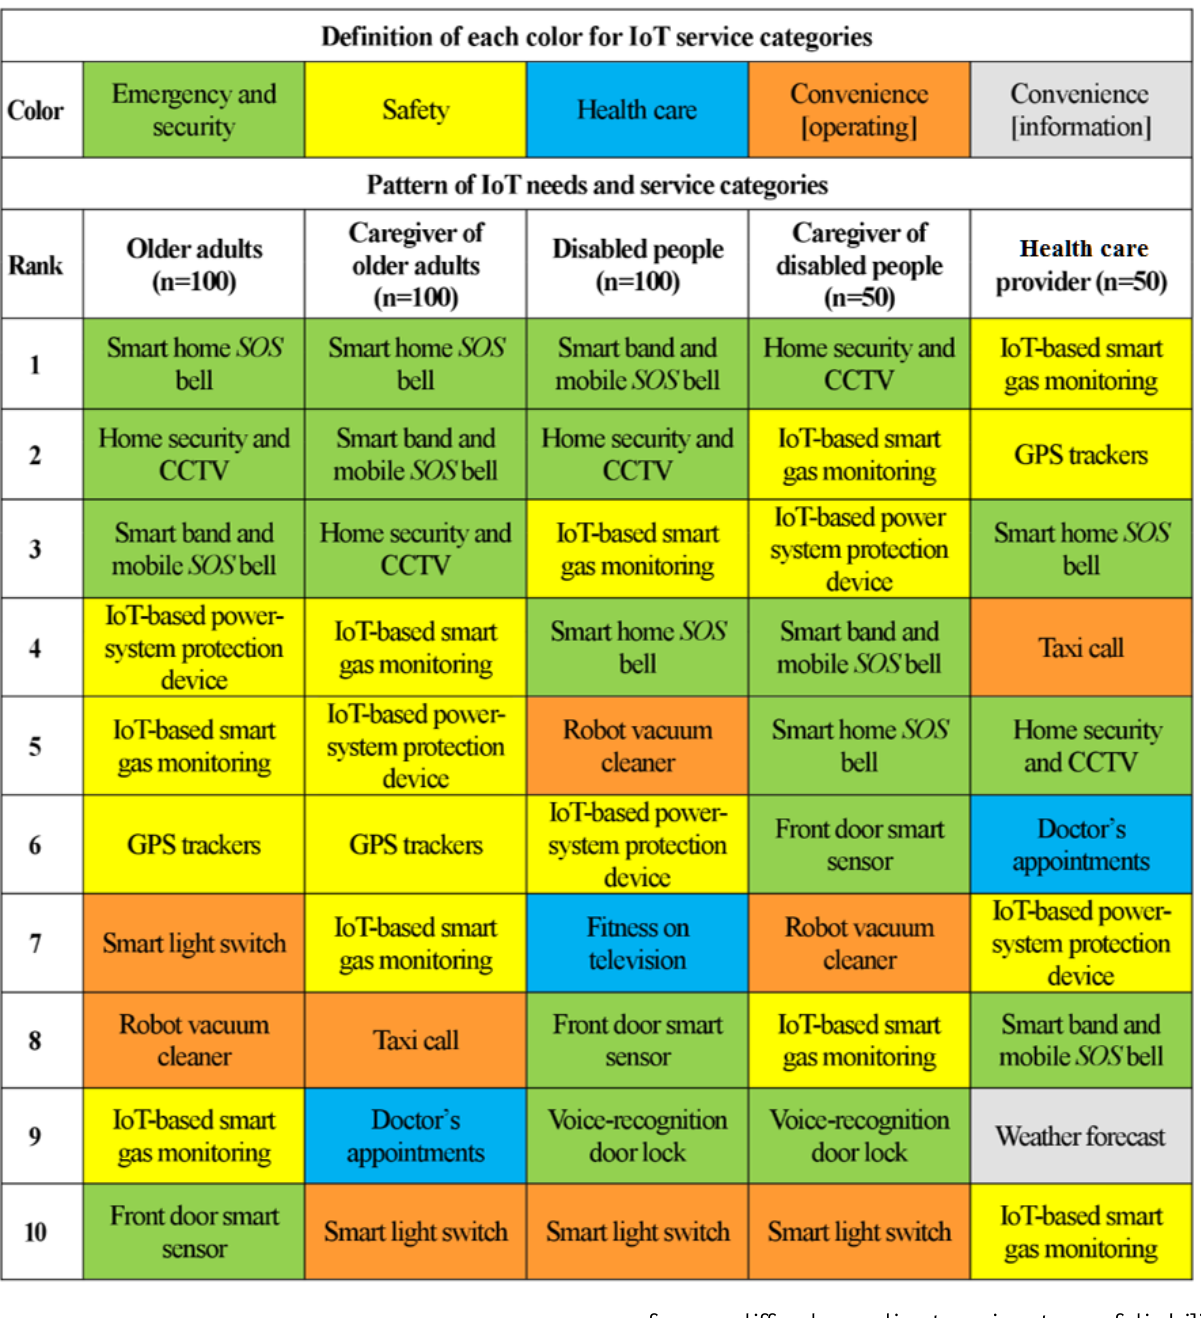
Figure 3. Weighted rankings of Internet of Things (IoT) services and needs depending on different groups. CCTV: closed-circuit